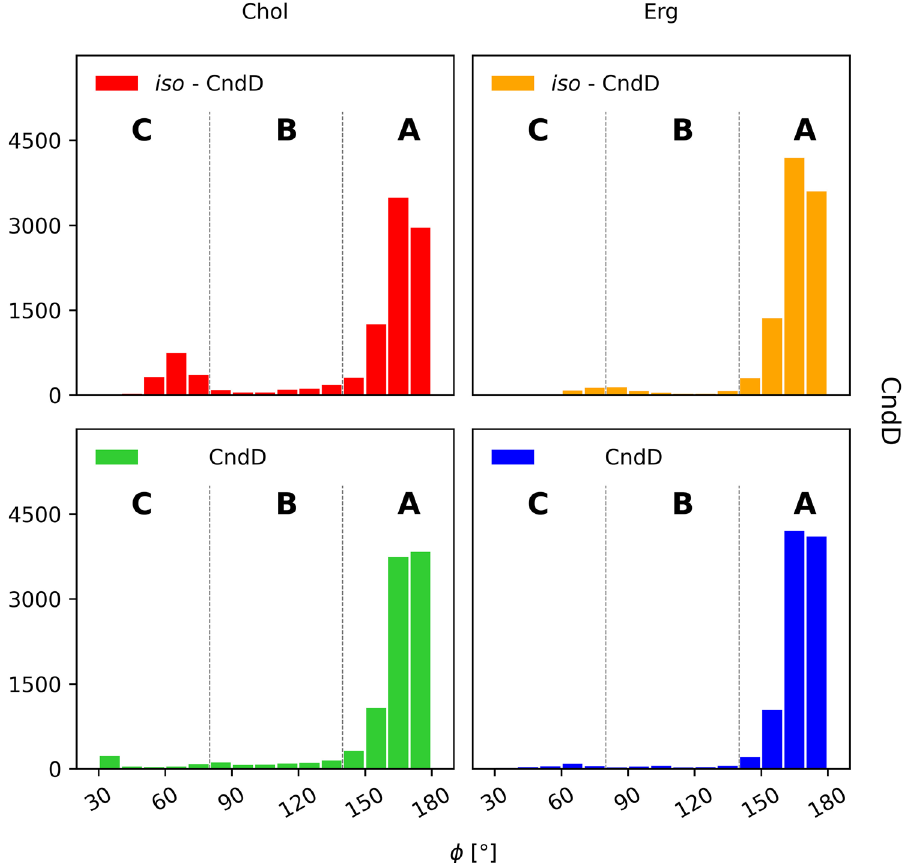
Figure 11. Distribution of the orientation of the (iso-)candicidin’ D alkyl-aromatic sidechain in relation to the rest of the molecule: ( A )—aligned; ( B )—bent; ( C )—tucked